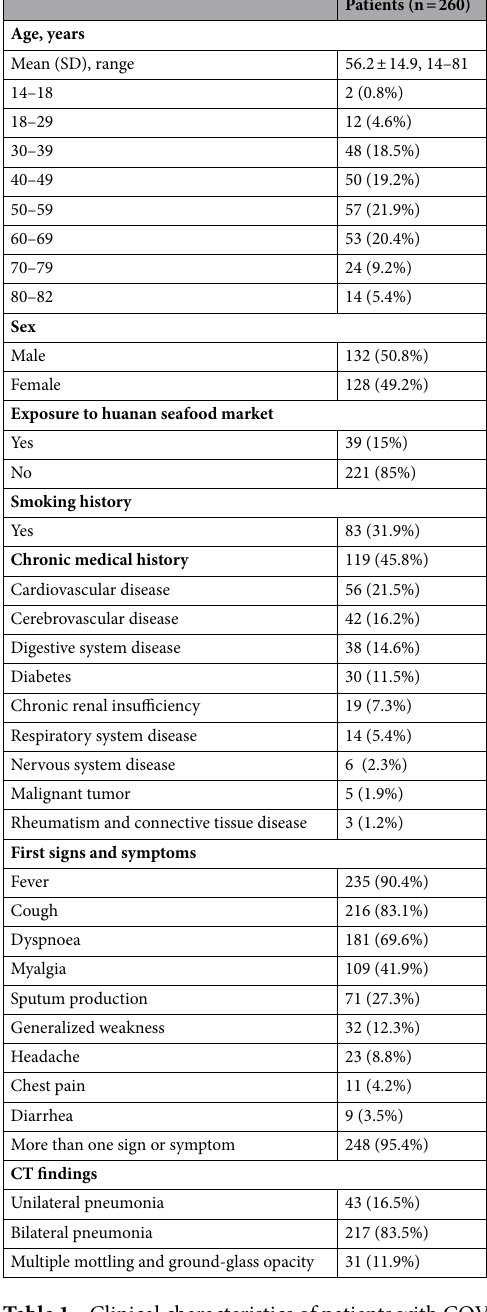
Table 1. Clinical characteristics of patients with COVID-2019 on